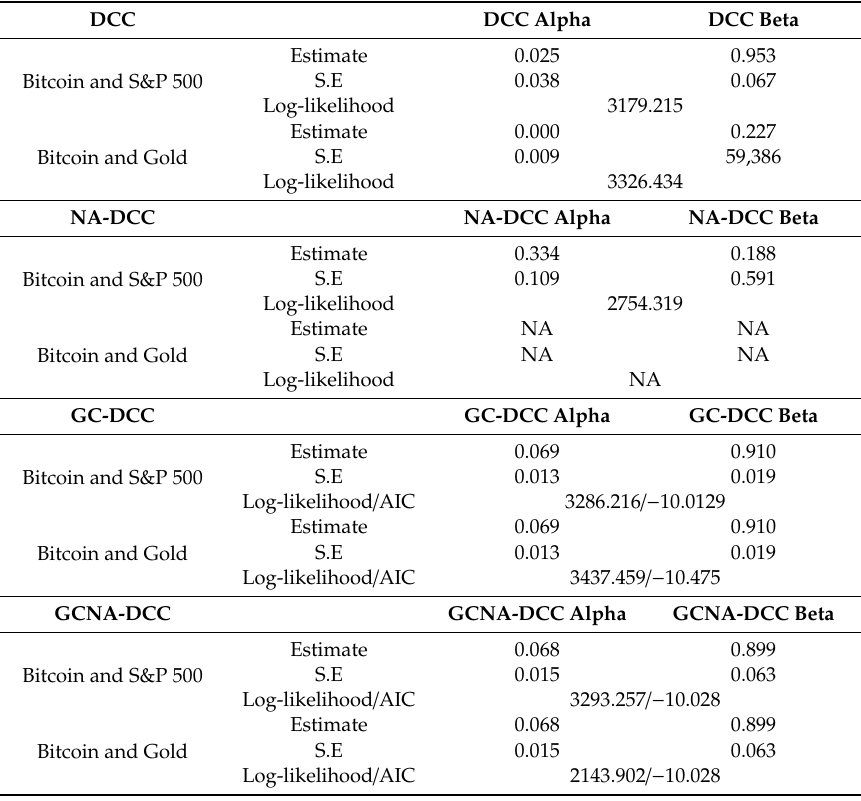
Table 8. The results of DCC with LBTC and LSP and with LBTC and LGD. Alpha and beta are